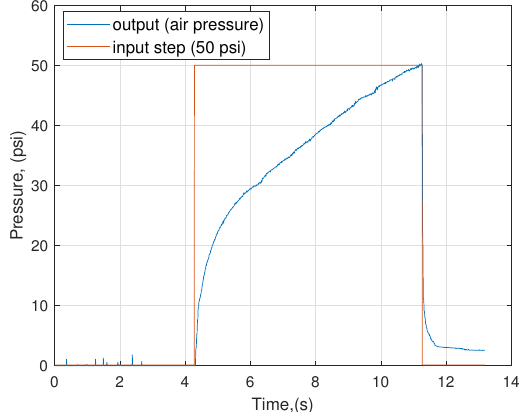
Figure 4. Transient response of the FISAs system that was obtained